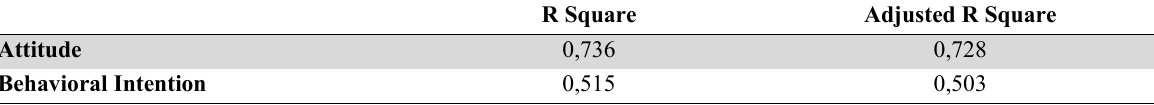
The results of R-Square R Square Adjusted R Square Attitude 0,736 0,728 Behavioral Intention 0,515